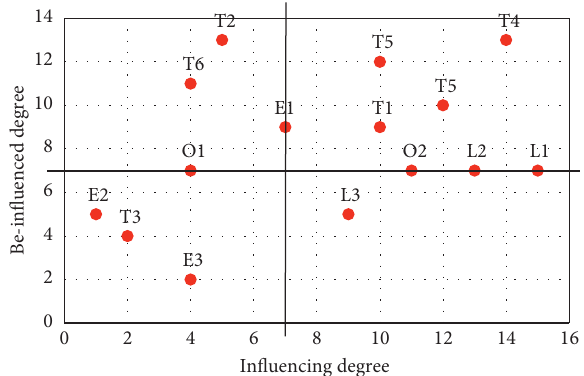
Figure 7: MICMAC